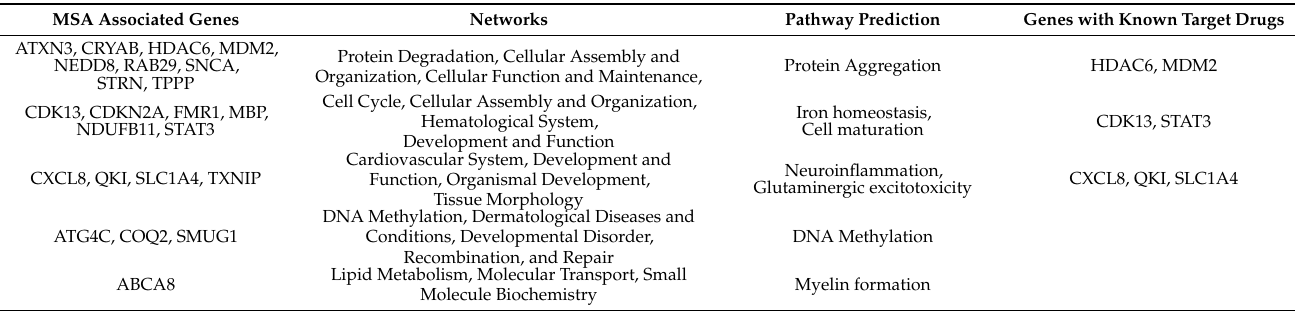
Table 2. Oligodendrocyte lineage genes with predicted pathways involved in